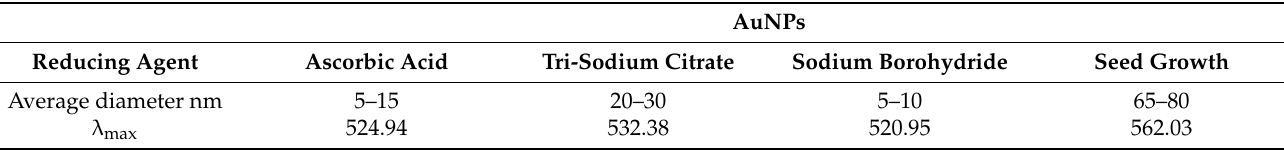
Figure 1. UV-vis absorption spectra of ( a ) gold salt and ( b ) gold nanoparticles. The maximum wavelength absorption (lambda maximum ( λ max )) of the different sizes of metal nanoparticles obtained using different reducing agents were measured. The lambda maximum ( λ max ) of the plasmonic peak varied with the reduction, as shown in Table 1. The λ max of AuNPs reduced with sodium borohydride (NaBH 4 ) was shorter than the λ max of AuNPs synthesized using other reducing agents. This may be due to the λ max dependence on the size of the nanoparticles in solution, since NaBH 4 nanoparticles were the smallest in size. Table 1. Synthesized AuNPs using different reducing agents .